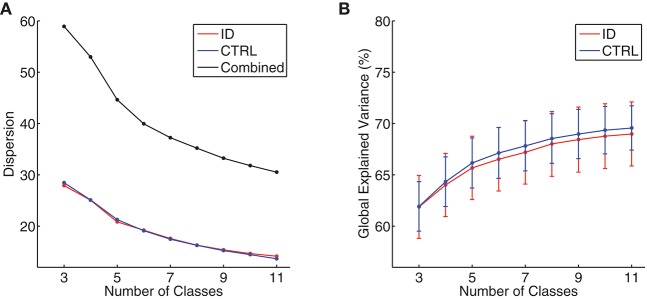
(A) Group-level dispersion (i.e., within-cluster global dissimilarity) for 3- to 11-class models, displayed separately for people with Insomnia Disorder (ID, red line), healthy controls (CTRL, blue line), and all participants combined (black line). (B) Mean percentages of global variance explained by all microstate classes when microstate topographies resulting from 3- to 11-class models were fitted back to individual EEG data, displayed separately for people with Insomnia Disorder (ID, red line) and healthy controls (CTRL, blue line). Error bars indicate 95% confidence intervals.